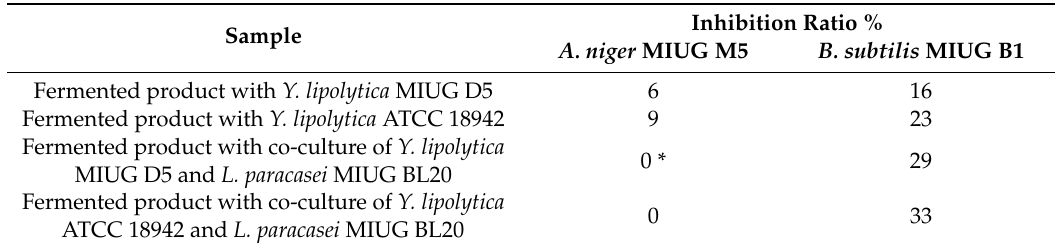
Table 2. Antimicrobial activity of the fermented product against A. niger and B. subtilis.